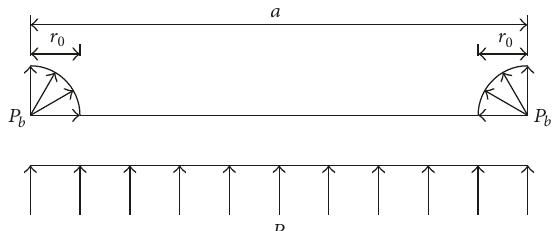
Figure 2: The equivalent load exerting on lines of centers of blast holes.